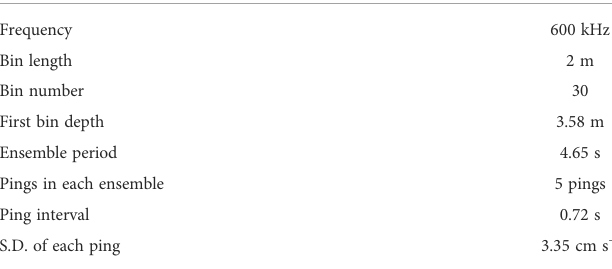
TABLE 2 ADCP operation parameters.